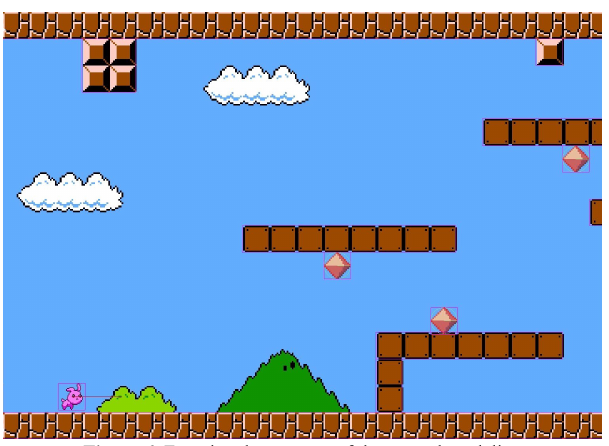
Figure 6. Functional prototype of the second